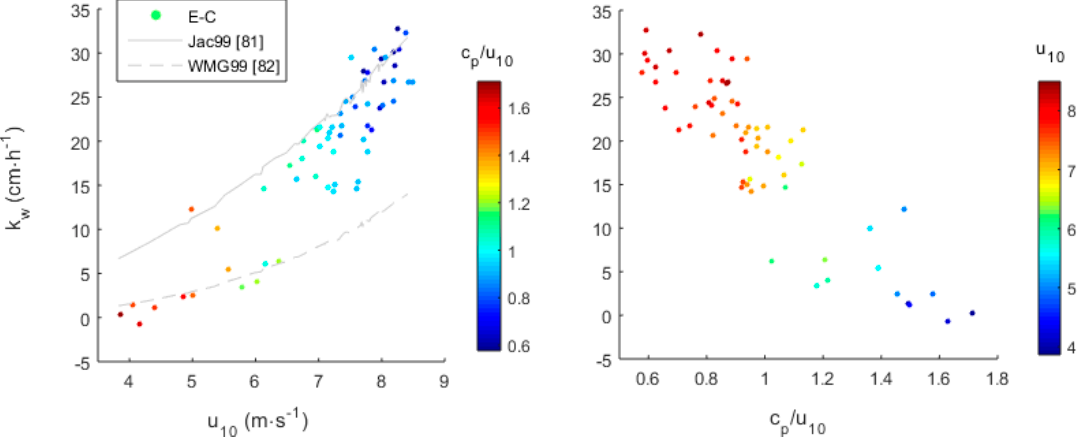
Figure 4. Transfer velocities (k w ) estimated for the Baltic experiment from eddy–covariance observations (E–C). The Jac99 (Jacobs et al. [81]) and WMG99 (Wanninkhof and McGillis [82]) are the empirical u 10 –based parameterizations estimating higher and lower k w within this wind range.